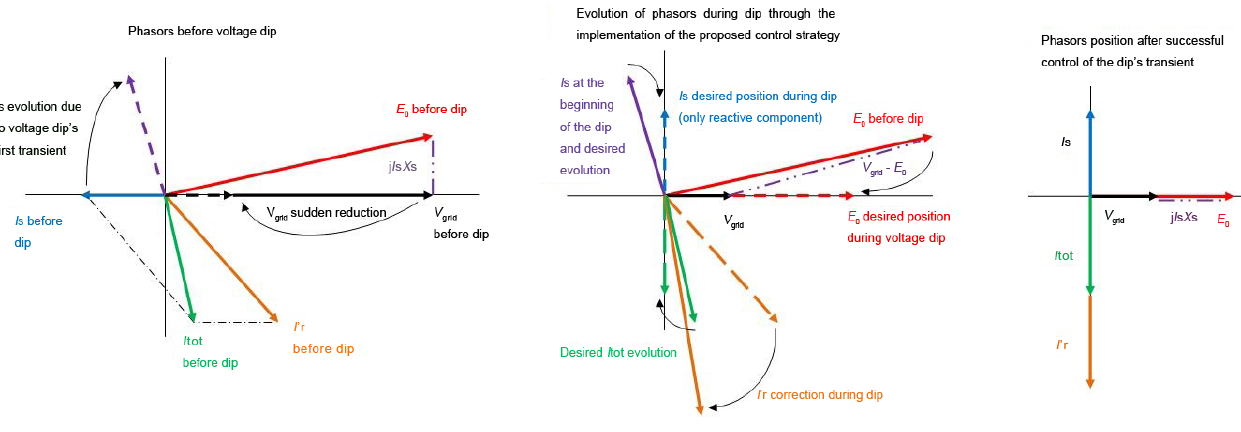
Figure 5. Desired evolution of DFIG phasors during voltage sag, through implementation of proposed control strategy. Initially only active power was being delivered to the